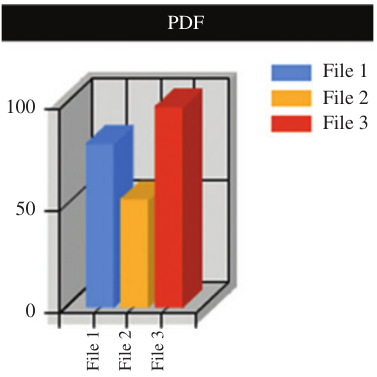
Figure 8. PDF Chart in 3D Bar Format.